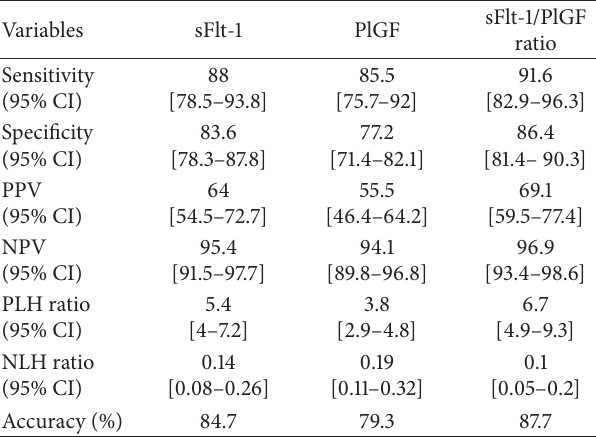
Figure 6: Receiver operating characteristic (ROC) curve of sFlt- 1/PlGF ratio in the prediction of preeclampsia. Area under the curve (AUC) = 0.916 (95% CI: 0.877 to 0.955; 𝑃 < 0.0001 ). Table 6: Sensitivity, specificity, PPV, NPV, PLH ratio, NLH ratio, and accuracy of sFlt-1, PlGF, and sFlt-1/PlGF ratio at the optimum cutoff value for prediction of